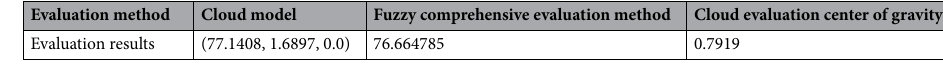
Table 20. Evaluation results